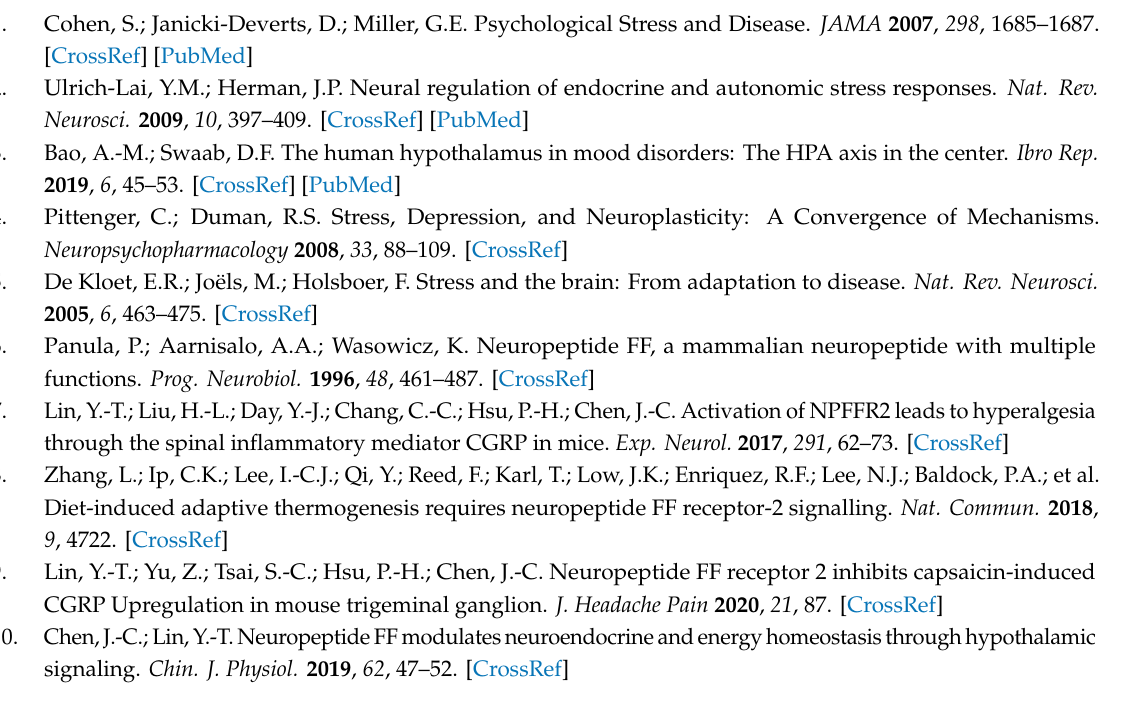
Figure S1: The behavioral profiles of male NPFFR2 KO mice. Figure S2: The behavioral profiles of female NPFFR2 KO mice. Figure S3: The dexamethasone suppression test in male WT